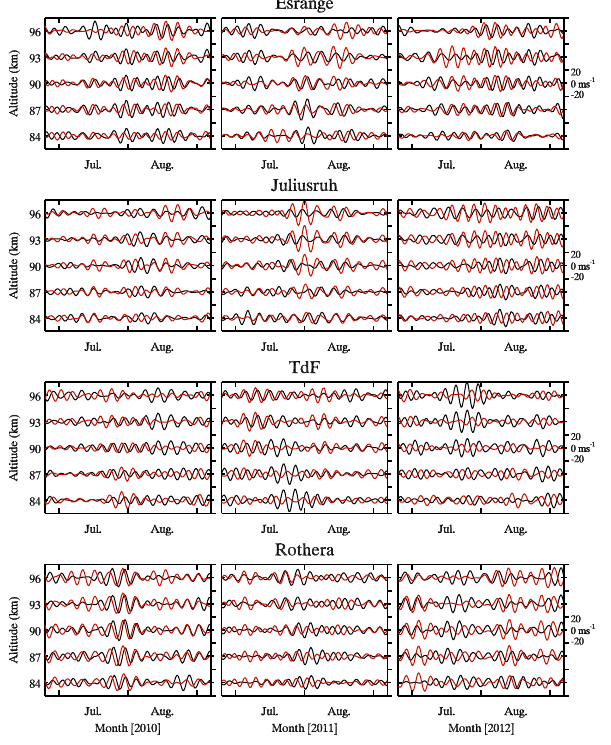
Figure 4. Hourly 5DW winds at altitudes between 84 and 96km for July and August of 2010 (left), 2011 (center), and 2012 (right) over Esrange, Juliusruh, Tierra del Fuego, and Rothera from top to bottom. Zonal and meridional winds are in black and red.